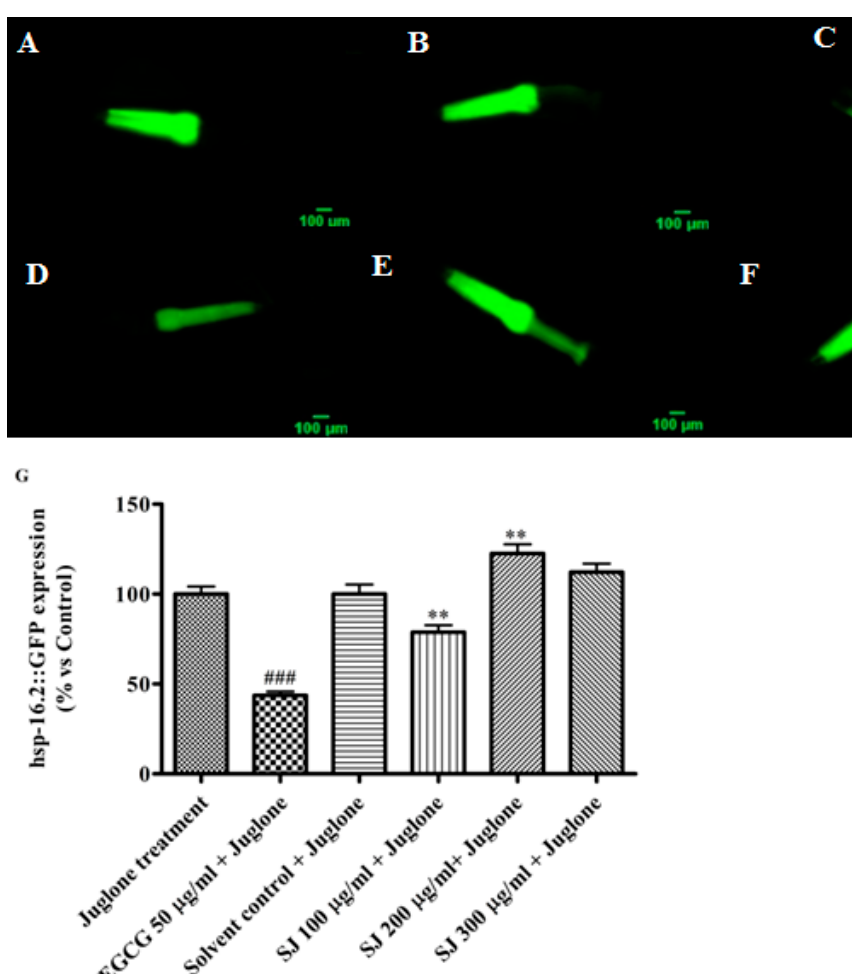
Figure 4. Hsp-16.2 gene expression in C. elegans . ( A – F ) GFP images of TJ375 worms from different treatment groups: ( A ) juglone group, ( B ) solvent control + juglone, ( C ) EGCG 50 µ g / mL + juglone, ( D ) SJ 100 µ g / mL + juglone, ( E ) SJ 200 µ g / mL + juglone, ( F ) SJ 300 µ g / mL + juglone, and ( G ) quantification